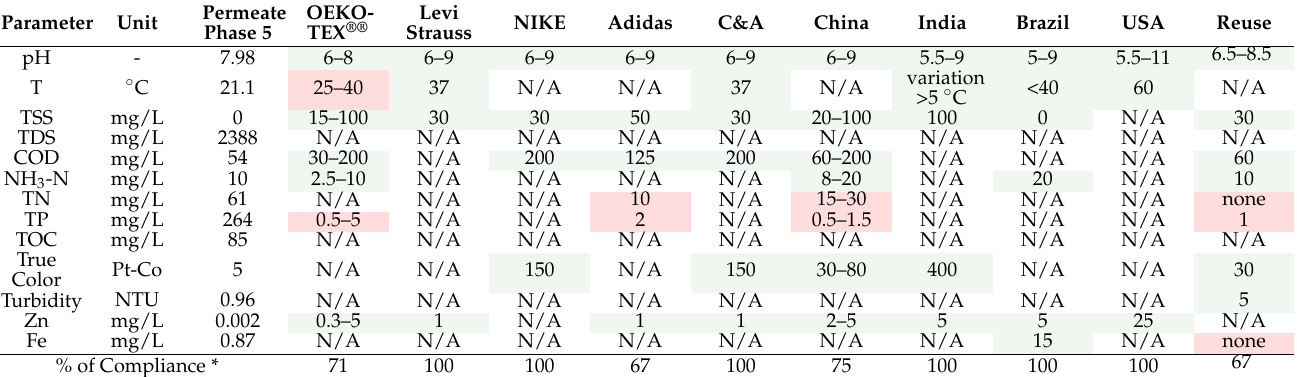
N/A: Not available. * Compliance related only to parameters in the table. Green background: experimental result is in compliance with respective law/standard/regulation. Red background: experimental result is not in compliance with respective